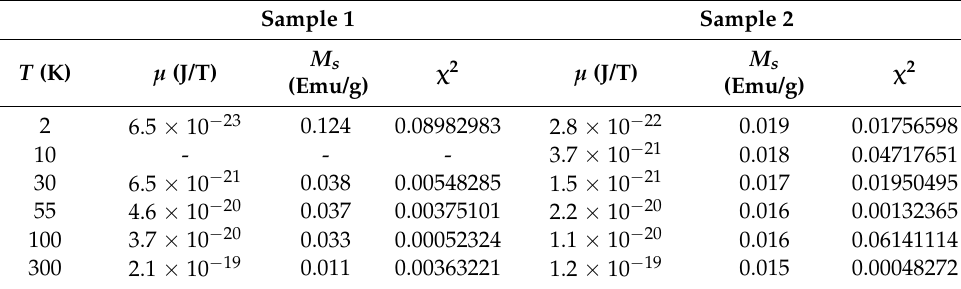
Table 1. Fit parameters for Langevin function. Sample 1 Sample